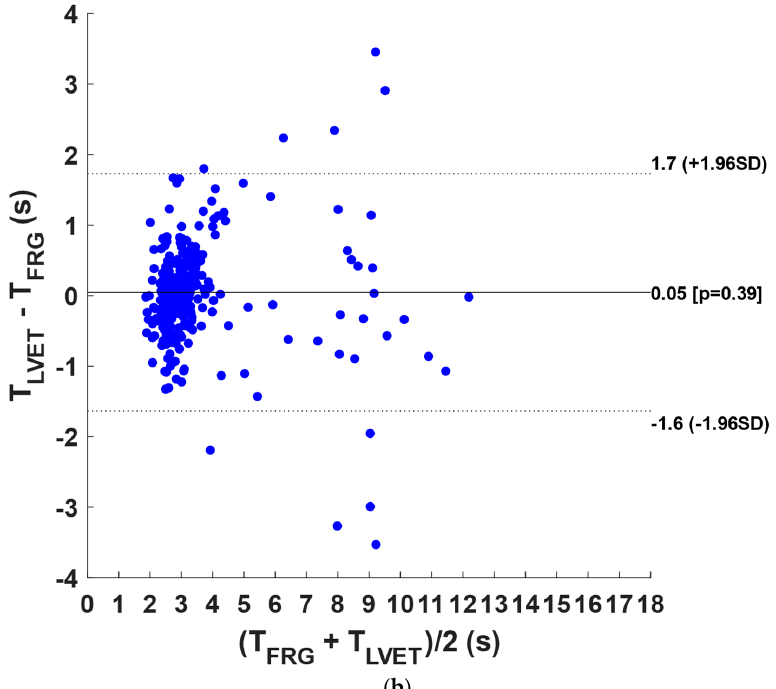
Figure 6. Statistical analyses on inter-breath intervals extracted from FRG and LVET time trends: ( a ) results of linear regression; ( b ) results of Bland–Altman analysis.